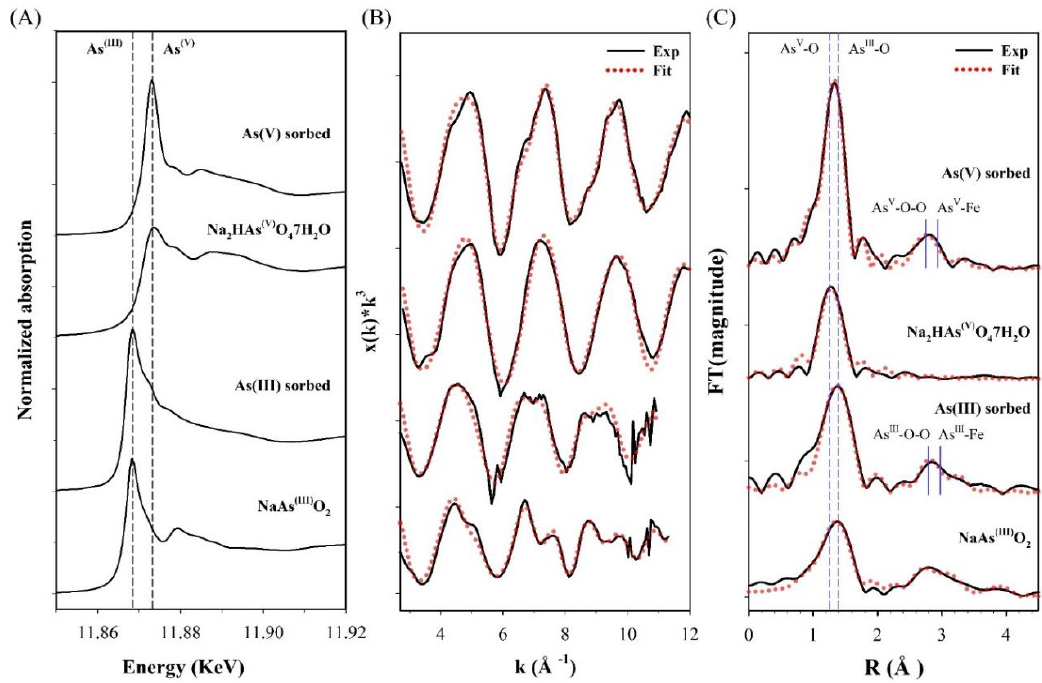
Figure 10. X-ray absorption spectroscopy (XAS) analysis for the arsenic (III and V)-sorbed CF-NCs and reference samples. ( A ) Normalized X-ray absorption near edge structure (XANES) spectra, ( B ) k 3 -weighted χ(k) extended X-ray absorption fine structure (EXAFS) spectra, and ( C ) Fourier transform of the χ(k) EXAFS spectra.